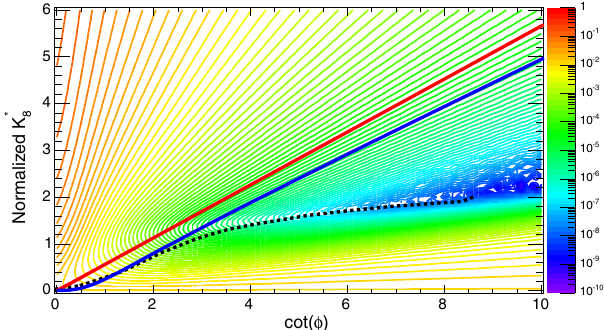
FIG. 6. Integral beam intensity to total at outside of 2 . 5 σ linear optics and solid red and blue lines are the same as shown in Fig. 3. The black dotted line stands for the curve to be achieved minimum value for various K (cid:1) 8